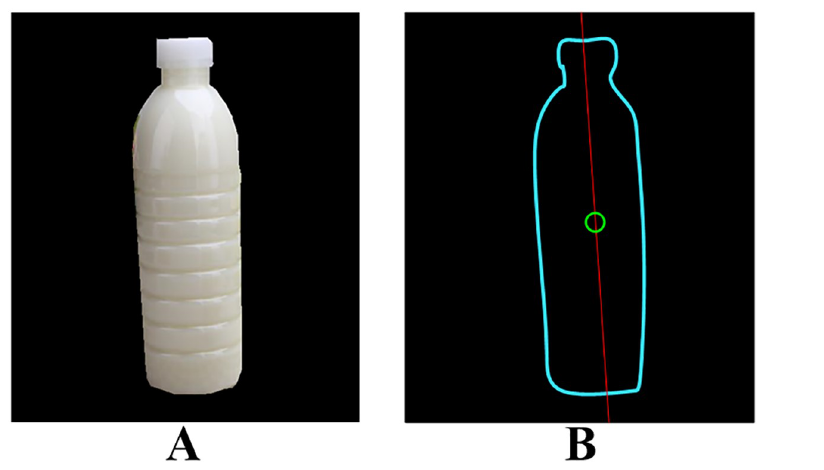
Fig 2. Commodity original and outline images (A is the original image; B is the outline image).